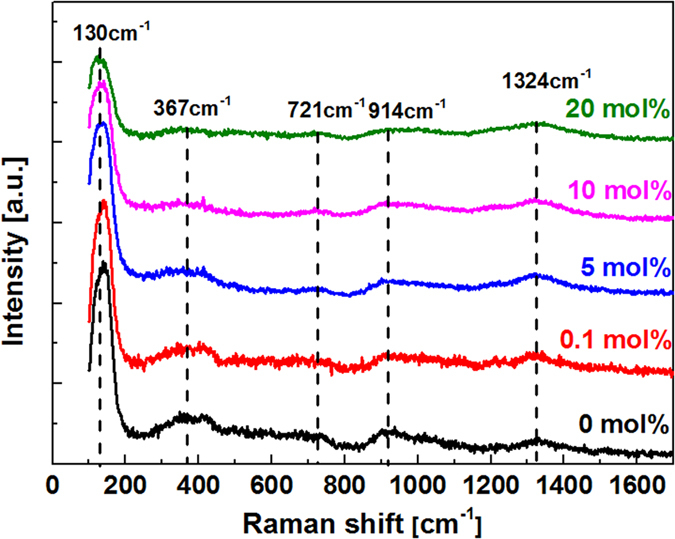
Raman spectra of samples doped with different concentration of CeO2.